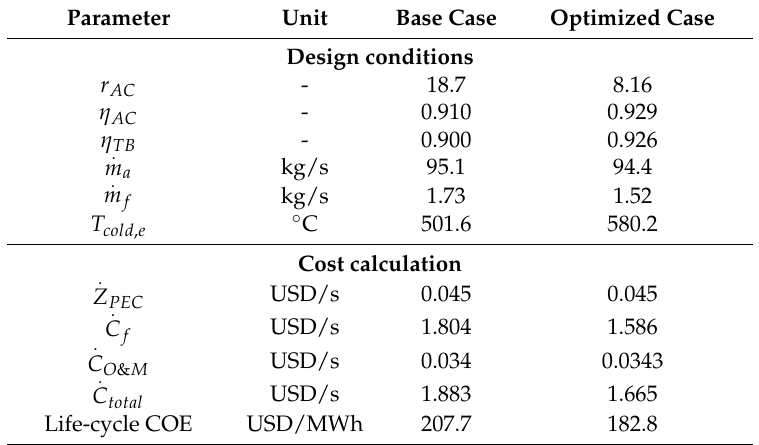
Table 9. Optimization results and relevant cost calculation for regenerative cycle.